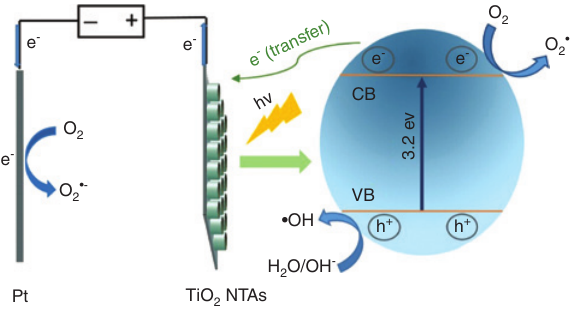
Figure 21: Schematic diagram for photoelectrocatalytic degradation of pollutants under UV